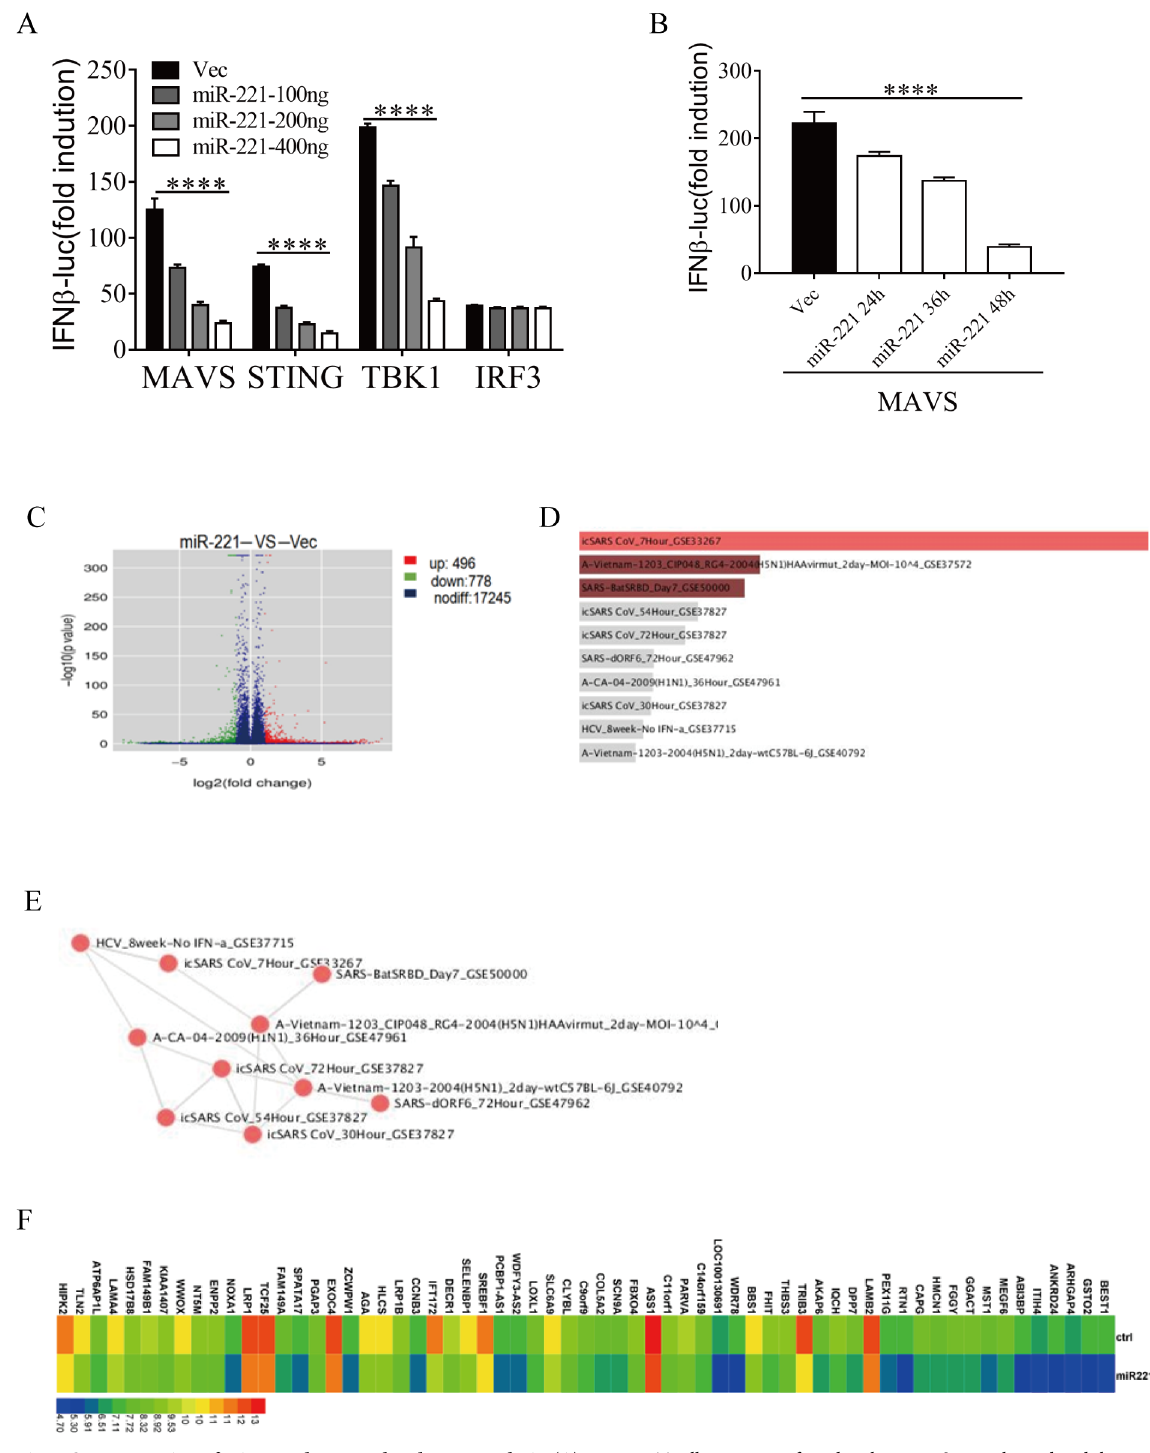
Fig 4. Overexpression of miR-221 downregulated genes analysis. (A) HEK 293T cells were transfected with an IFN β -Luc plasmid and the indicated plasmids. Cells were then given miR-221 or an empty vector (Vec) control. (B) HEK 293T cells were transfected with an IFN β -Luc plasmid, MAVS and empty vector (Vec) or miR-221. The data are expressed as the mean ± SEM of 2 independent experiments. (n = 2 biological replicates). (C) HEK 293T cells were transfected with miR-221 or empty vector (Vec). 6 hours later the cells were harvested followed by whole genome RNA-seq analysis. (D) enrichment analysis using “Virus Perturbations from GEO down” section of “Enrichr” program. (E) Network graph of downregulated genes, showing top ten clusters. (F) Heatmap of top ten clusters of downregulated genes.